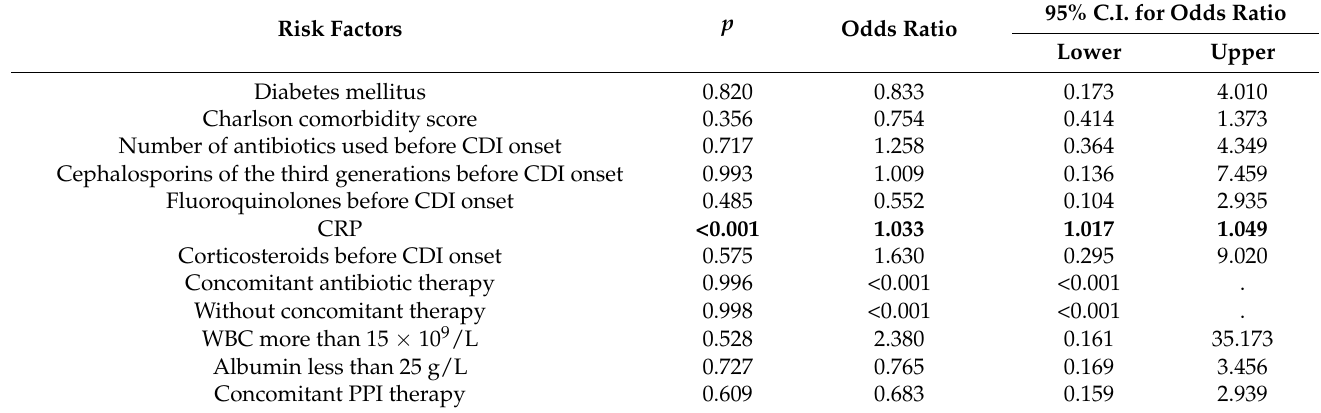
Table 3. Predictors of the lethal outcome in CDI before